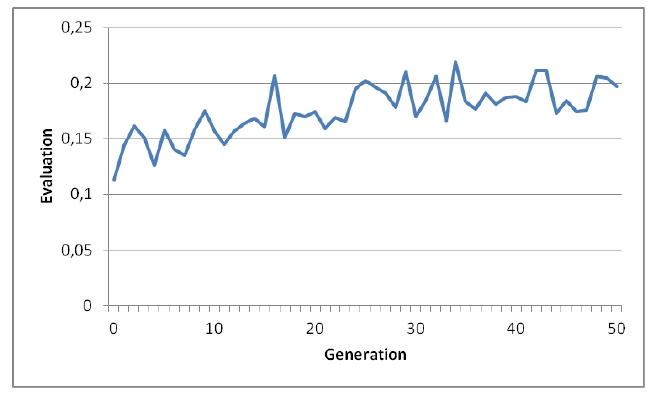
Fig. 6. Evolution of the average evaluation in each generation considering five runs.